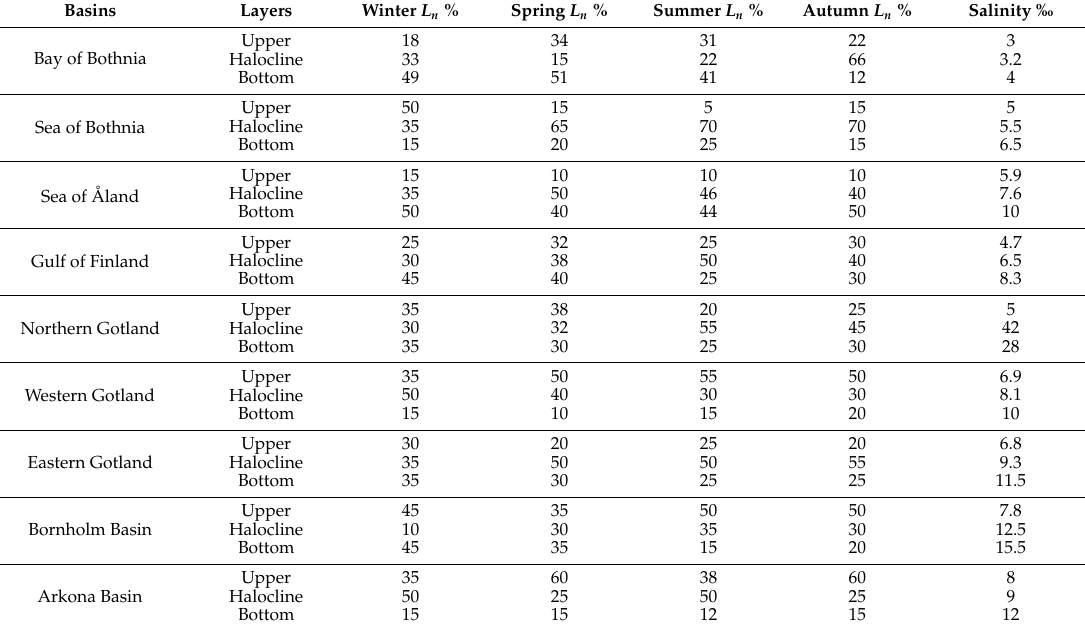
Basins Layers Bay of